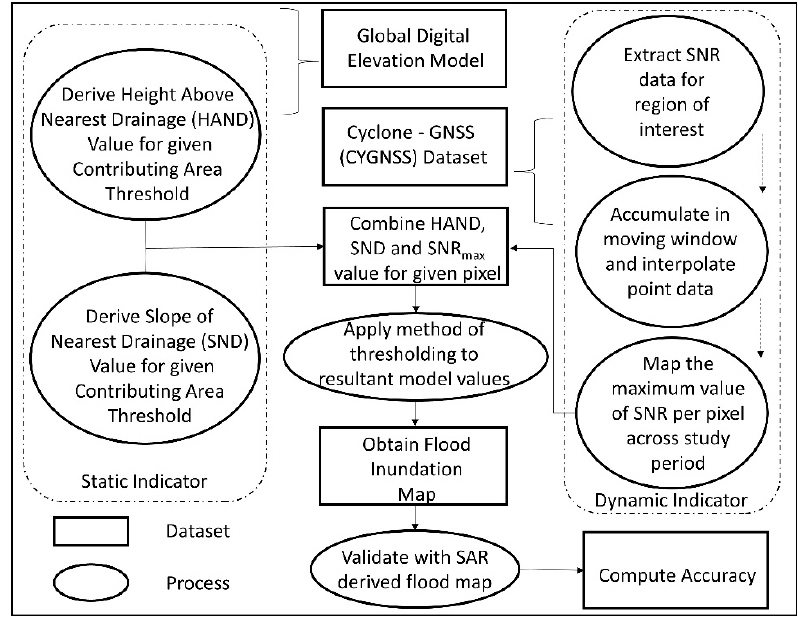
Figure 1. Workflow of the conceptual flood inundation mapping technique undertaken in this